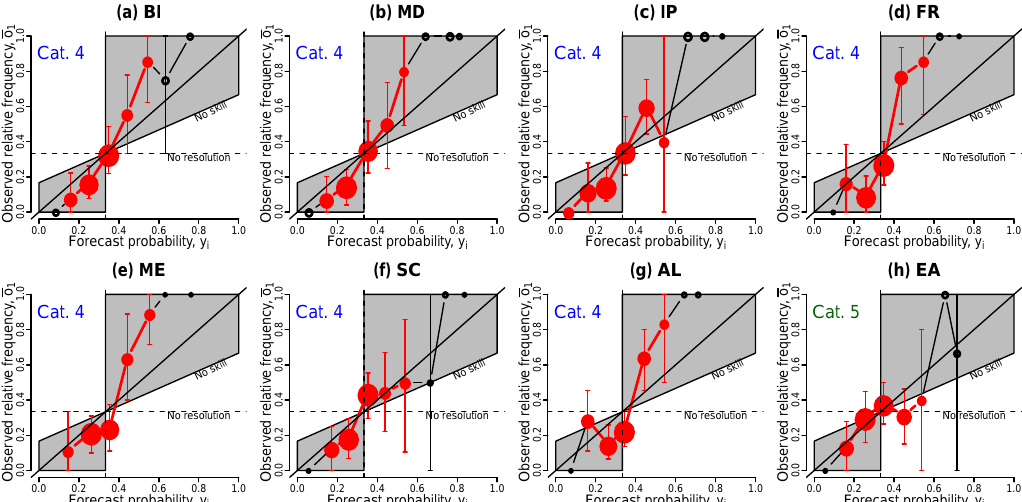
Figure 13. Reliability diagrams for high summer temperature for each sub-region, defined as seasonally averaged JJA temperature in the upper tercile over 1902–2006. Forecasts are grouped into bins of size 0.1 and their average value within each bin is plotted ( x -axis) versus the relative frequency observed in the corresponding years. The area of the dots is proportional to the number of forecasts within each bin, with bins containing less than 5 years shown in black (red dots indicate bins containing at least 5 years). Error bars are computed from 100 bootstrap samples using the “verification” R package (NCAR – Research Applications Laboratory, 2015). Grey shading indicates where data points contribute positively to skill (Wilks, 2011). Performance category is indicated in the upper left of each plot, on a scale from 1 (dangerously useless) to 5 (perfect) (see Table 3) as in Weisheimer and Palmer (2014).